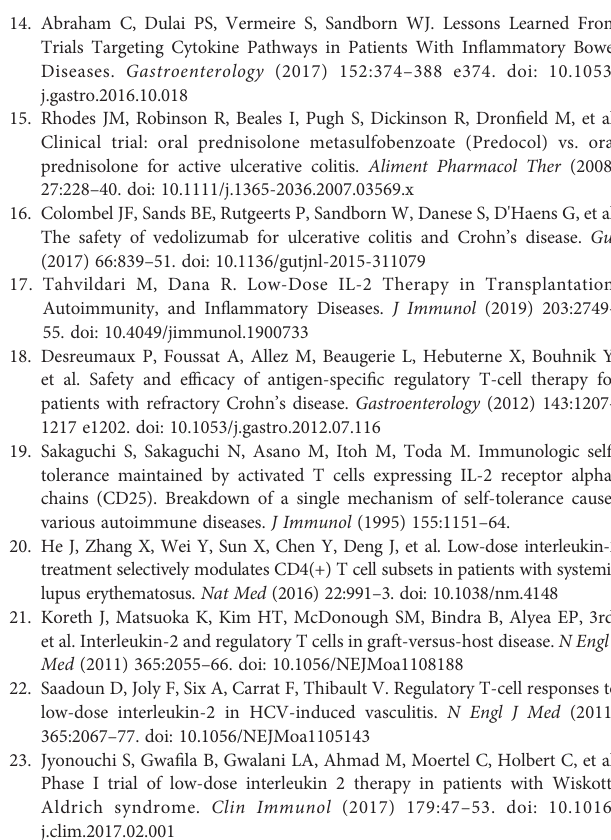
Supplementary Figure 1 | LD IL-2-mediated protection against TNBS colitis requires human immune cells. Weight loss following TNBS enema in NSG mice devoid of human cells treated with ( n = 7) or without ( n = 6) LD